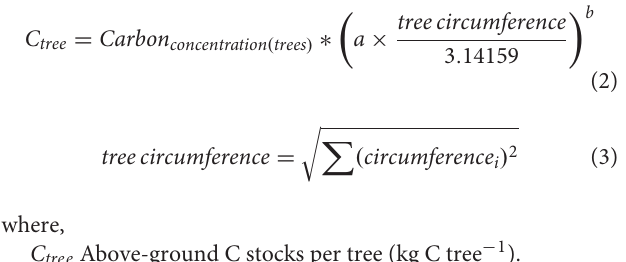
b Coefficient b ( Table 3 ). tree circumference cumulative tree stem circumference (cm) at 1.30 m tree height (breast height) measured outside tree bark. circumference i circumference (cm) at breast height of each individual stem i (i = 1,2, . . . ,n) of a tree with multiple